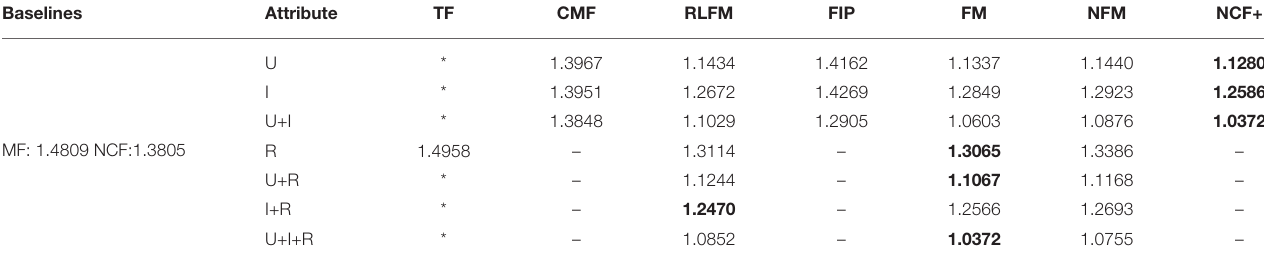
TABLE 11 | RMSE on Yelp.